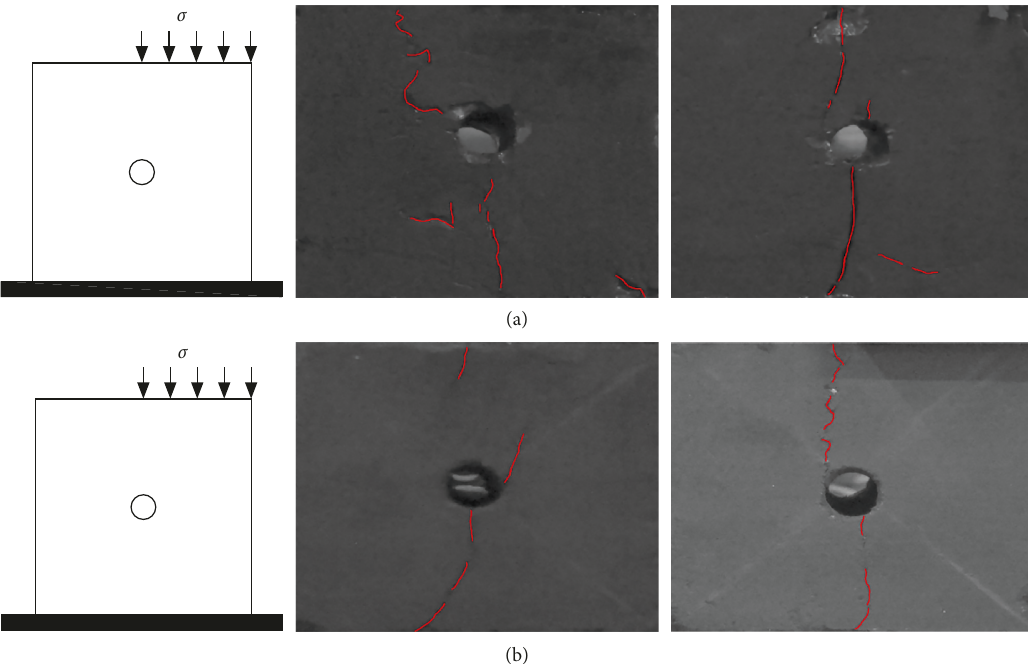
Figure 8: Action area of 2S/4. (a) Coal samples; (b) briquette samples.